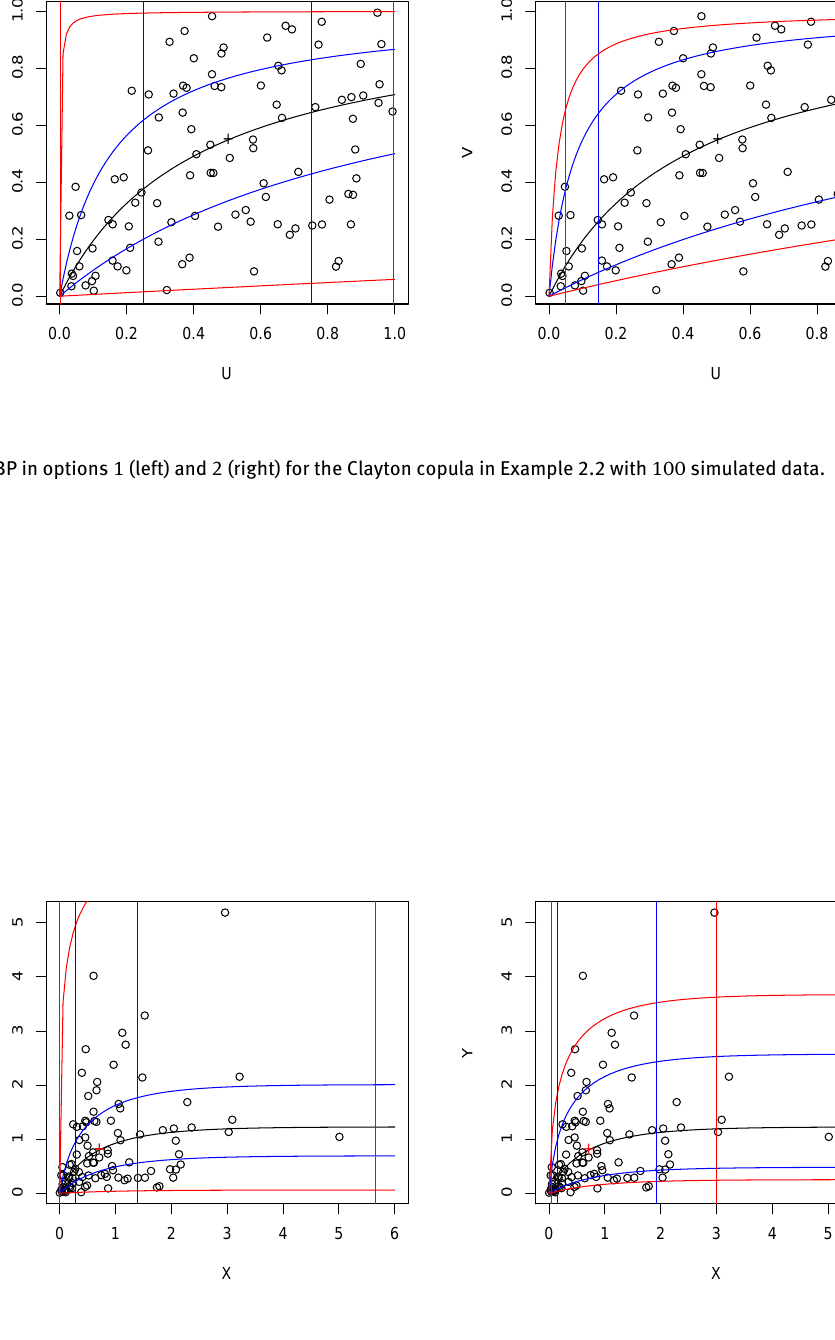
Figure 6: BBP in options 1 (left) and 2 (right) for the exponential model with the Clayton copula in Example 2.2 and 100 simu- lated